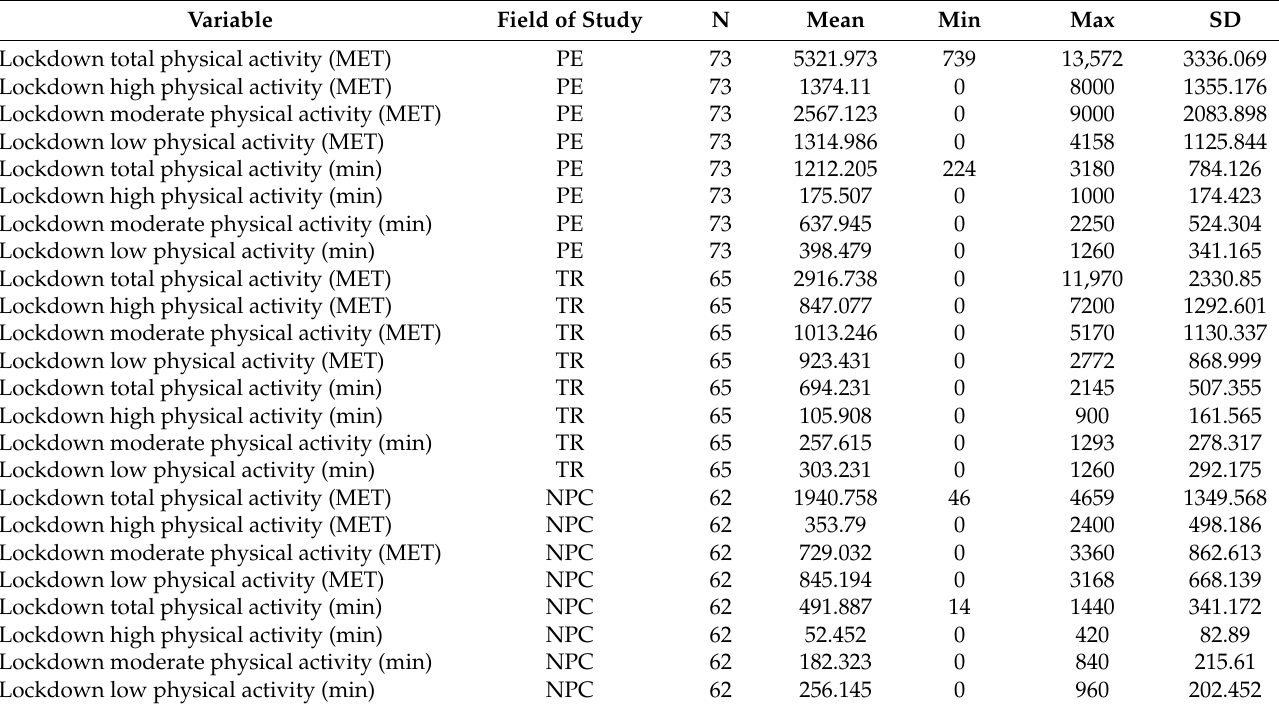
Table 1. MET scores and time spent in physical activity during the lockdown